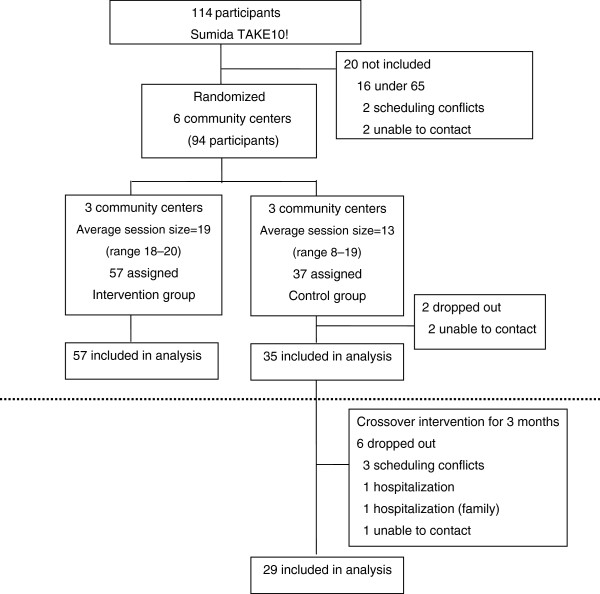
Participant flow.